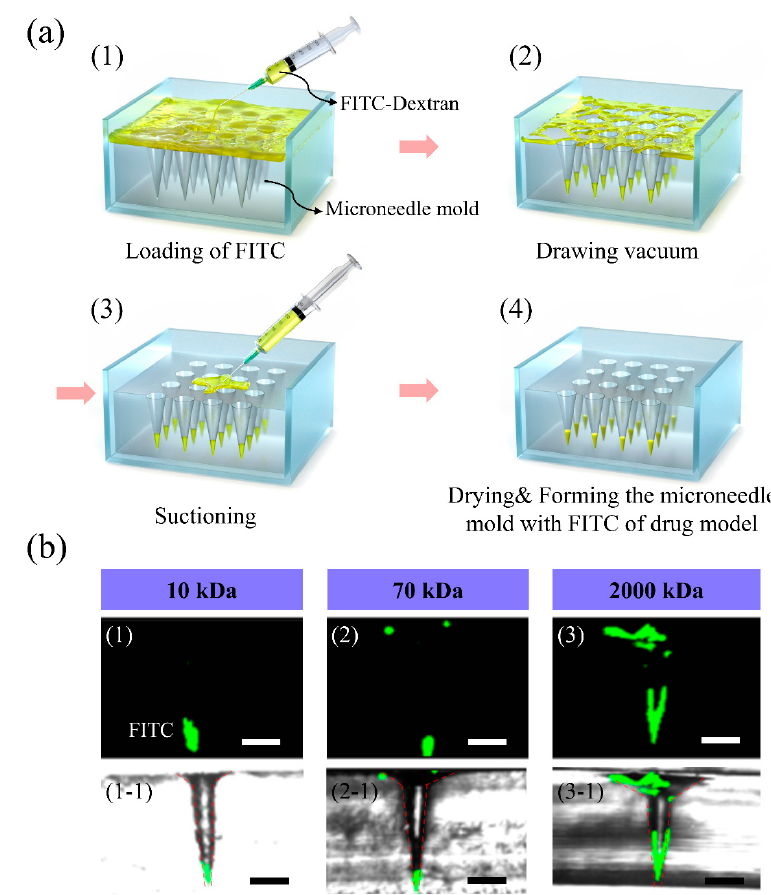
Figure 2. ( a ) Process of loading FITC-dextran of different molecular weights based on the dispensing and suction method. (1) Loading of the FITC-dextran solution into the prepared mold, (2) drawing vacuum, (3) suctioning, and (4) drying. ( b ) Merged optical and confocal microscopy images of FITC-loaded molds (1, 1-1) 10 kDa, (2, 2-1) 70 kDa, and (3, 3-1) 2000 kDa (scale bar: 200 μ m).